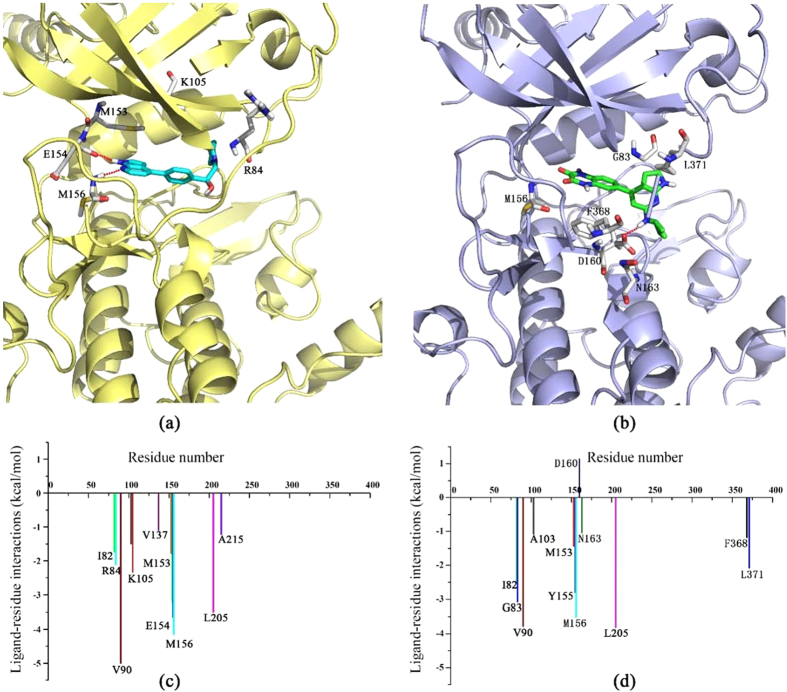
The averaged structures from the MD simulations for the (a) TS-15–ROCK1 complex and (b) TS-11–ROCK1 complex (carbon atoms of the key residues were colored in gray, and carbon atoms of the TS-15 and TS-11 were colored in cyan and green, respectively).The contributions of the key residues to the binding of (c) TS-15 and (d) TS-11.